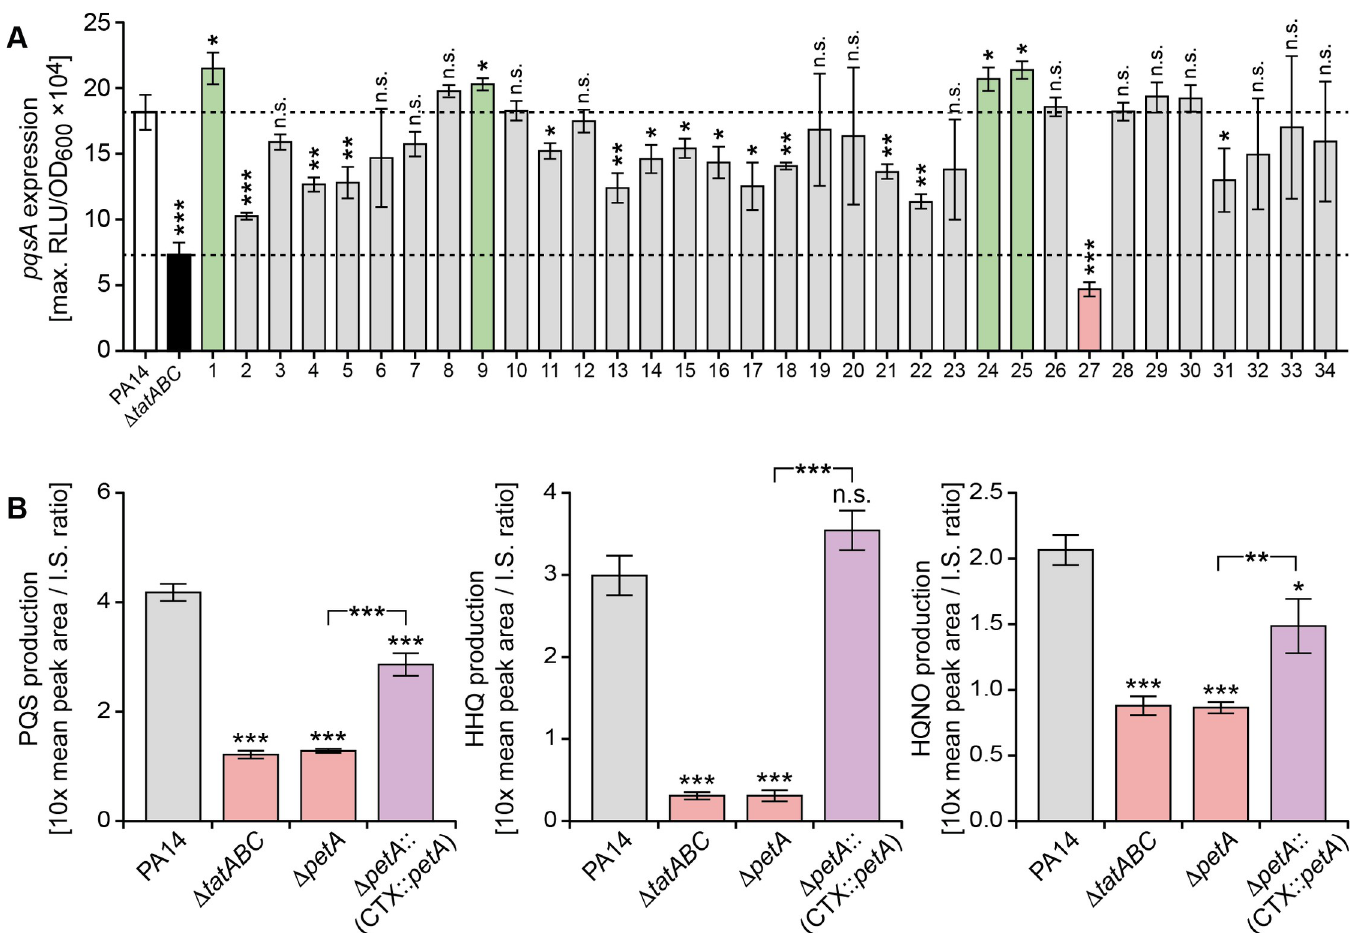
Fig 10. Tat substrate screen for P . aeruginosa PA14 mutants with defects in pqs signaling uncovers a role for the cytochrome bc of peak pqsA expression in each of 34 Tat substrate mutants ( S3 Table ) transformed with a CTX:: pqsA’-lux fusion compared with the PA14 wild type (white bar) and the Δ tatABC mutant (black bar). The bars represent mutants where pqsA expression is higher (green bar) or lower (grey bar) or the same (grey bar) as the wild type. PA14 mutant 27 (pink bar) has the lowest pqsA expression and carries a deletion in PA14-57570 ( petA ), the Rieske subunit of cytochrome bc and HQNO after 16 h growth by P . aeruginosa PA14, the Δ tatABC and Δ petA mutants and the genetically complemented PA14 mutant ( Δ petA ::(CTX:: petA )). ��� p < 0.001, �� p < 0.01, and � p < 0.05; n.s. not significant.